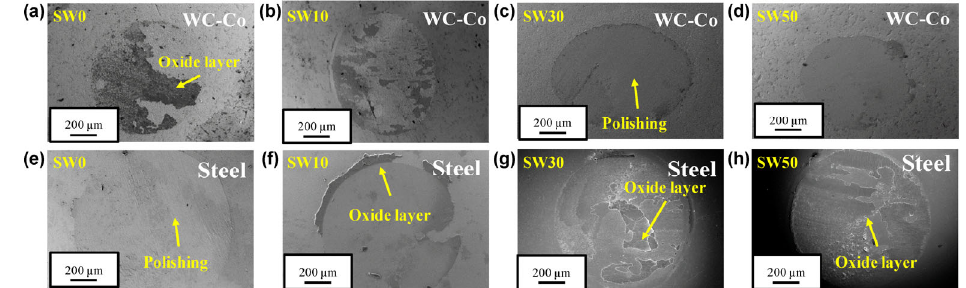
Fig. 11 SEM images of worn surfaces of counterbody (WC and steel ball) slid against SiC-WC composites at 20 N load.